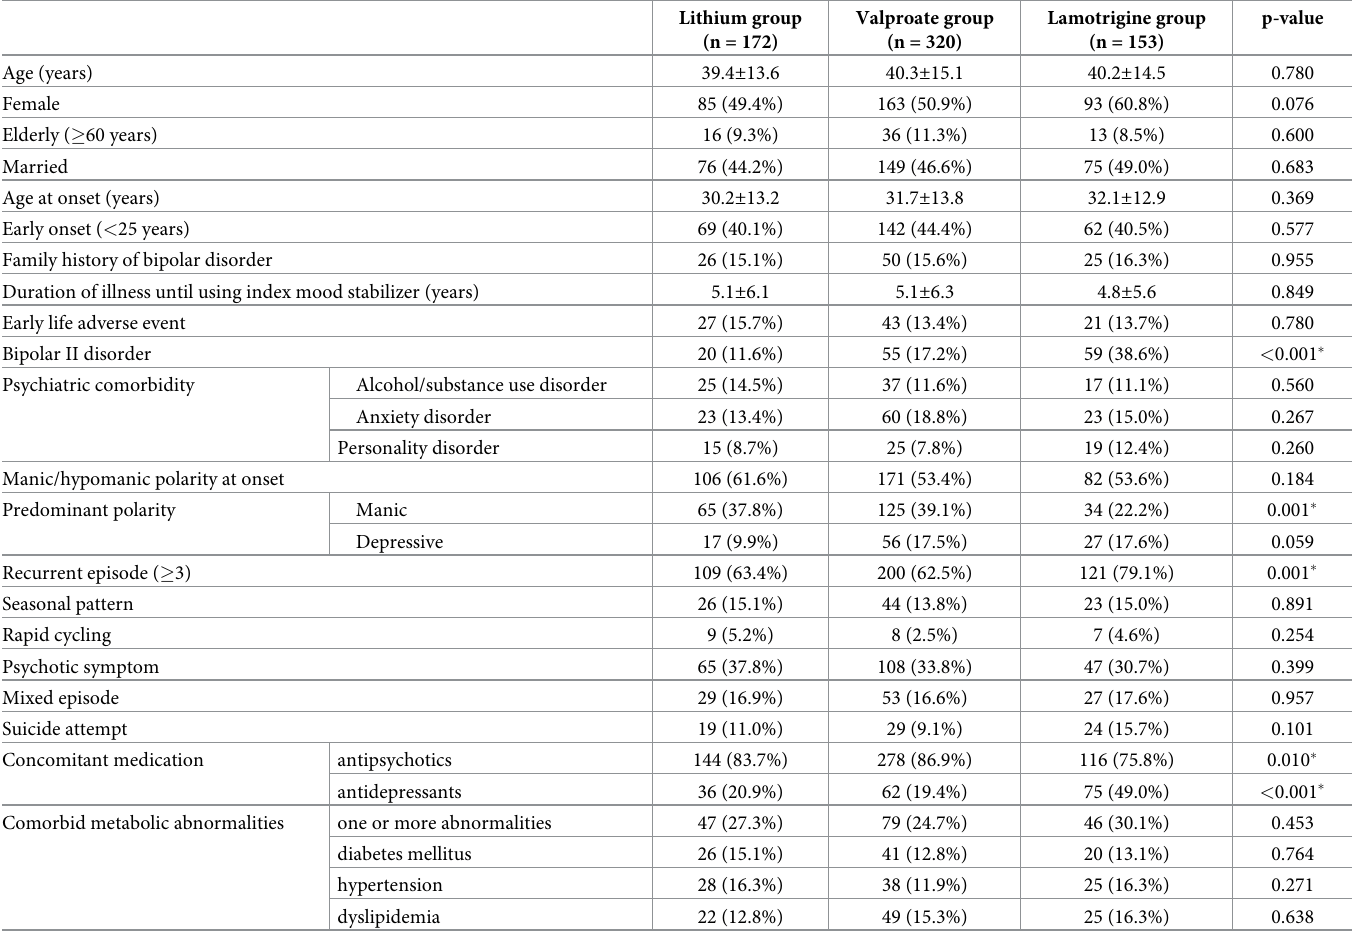
Table 1. Comparisons of sociodemographic and clinical characteristics among treatment